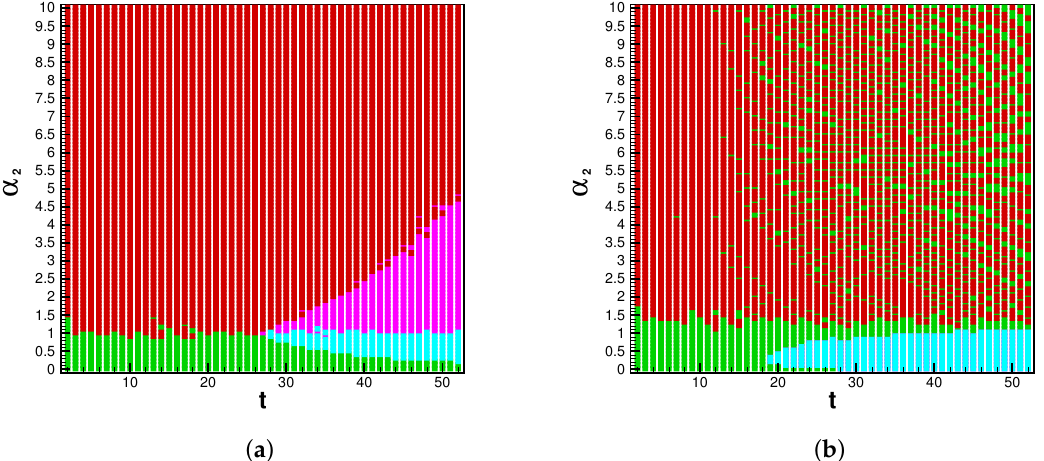
Figure 6. Phase planes depicting the dominant infection pathway for the flu season beginning ( a ) 2015 and ( b ) 2016 The colors green, cyan, red, and purple refer to the pathways A , BA , AB , and B ,